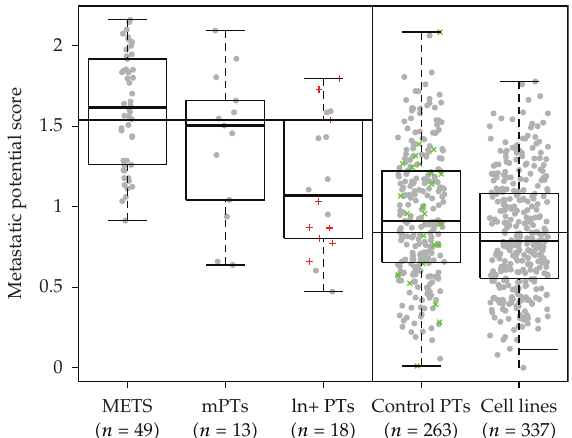
Figure 9: Boxplot showing the metastatic potential scores for all samples involved in the analysis. All high-risk tumors are shown in the left three boxes (cid:2) metastases, progressors, and lymph-node-positive samples (cid:3) , while unknown control primary tumors and the publically available cell line data are shown in the right boxes. The red “ (cid:9) ” symbols in the lymph-node-positive box represent those samples from the MSK dataset, distinguishing them from the SU cohort lymph-node-positive samples. The green “x” symbols in the control primary tumors plot represent selected low-risk primary tumors (cid:2) individuals with no biochemical recurrence (cid:2) PSA (cid:3) for at least 80 months (cid:3)